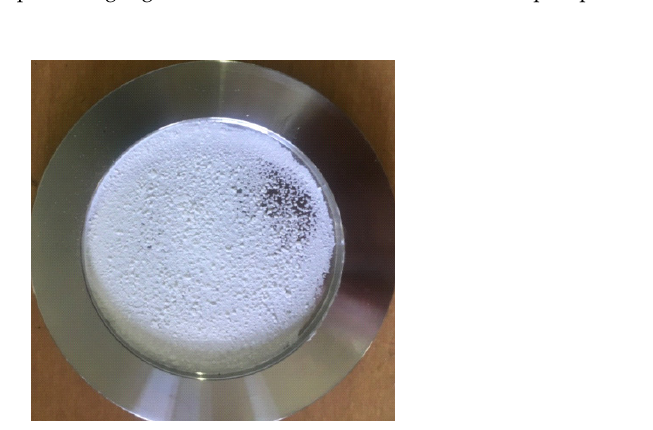
Figure 2. LiOH in the flat reactor (particle diameter of 32–40 µ m, 0.2–0.3 mm thickness of packing layer, and 120 mg weight).